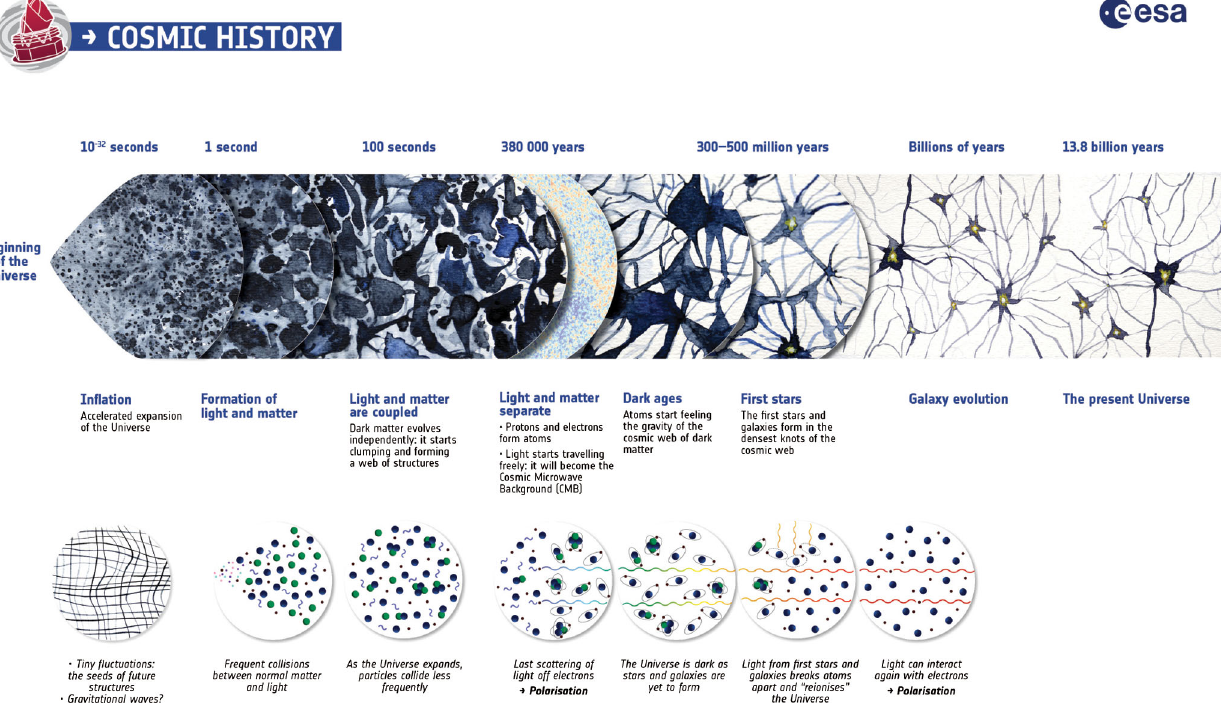
FIG. 15. Another variation of the evolutionary timeline of the Universe. Image credit: